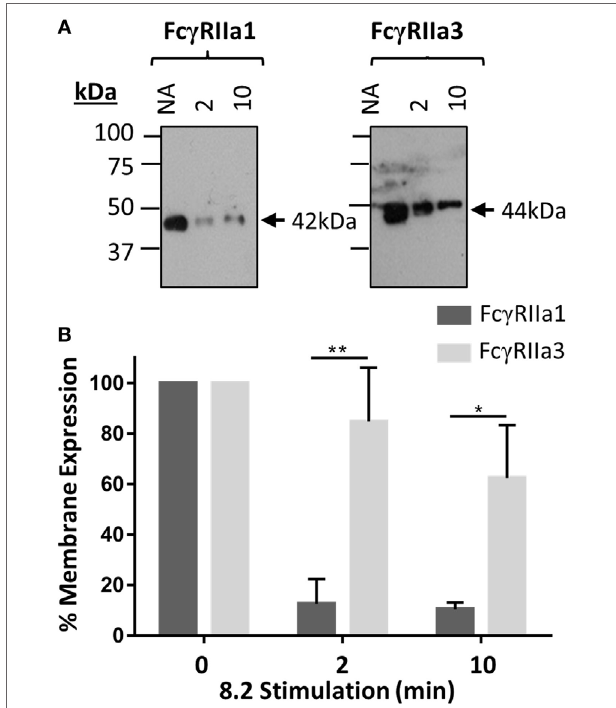
FigUre 3 | Time course of receptor expression at the plasma membrane following mAb (8.2) stimulation. (a) Western blot analysis of Fc γ RIIa precipitated from cells after stimulation with the non-blocking agonist Fc γ RIIa mAb 8.2 (20 µg/mL) at 37°C for the indicated time (minutes). Membrane fractions were isolated, receptor immunoprecipitated using IgG-conjugated beads, and subsequently probed using rabbit anti-Fc γ RIIa anti-sera. Molecular markers and size of Fc γ RIIa1 (42 kDa) and Fc γ RIIa3 (44 kDa) are indicated. (B) Densitometry of Fc γ RIIa1 and Fc γ RIIa3 intensity from three independent Western blot experiments. Intensity of Fc γ RIIa immuno- precipitation from unstimulated (no addition = NA) cells in each blot is taken as 100% (mean ± SEM, n =